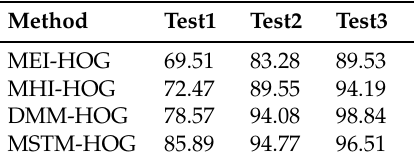
Table 3. The recognition rates (%) of different methods on